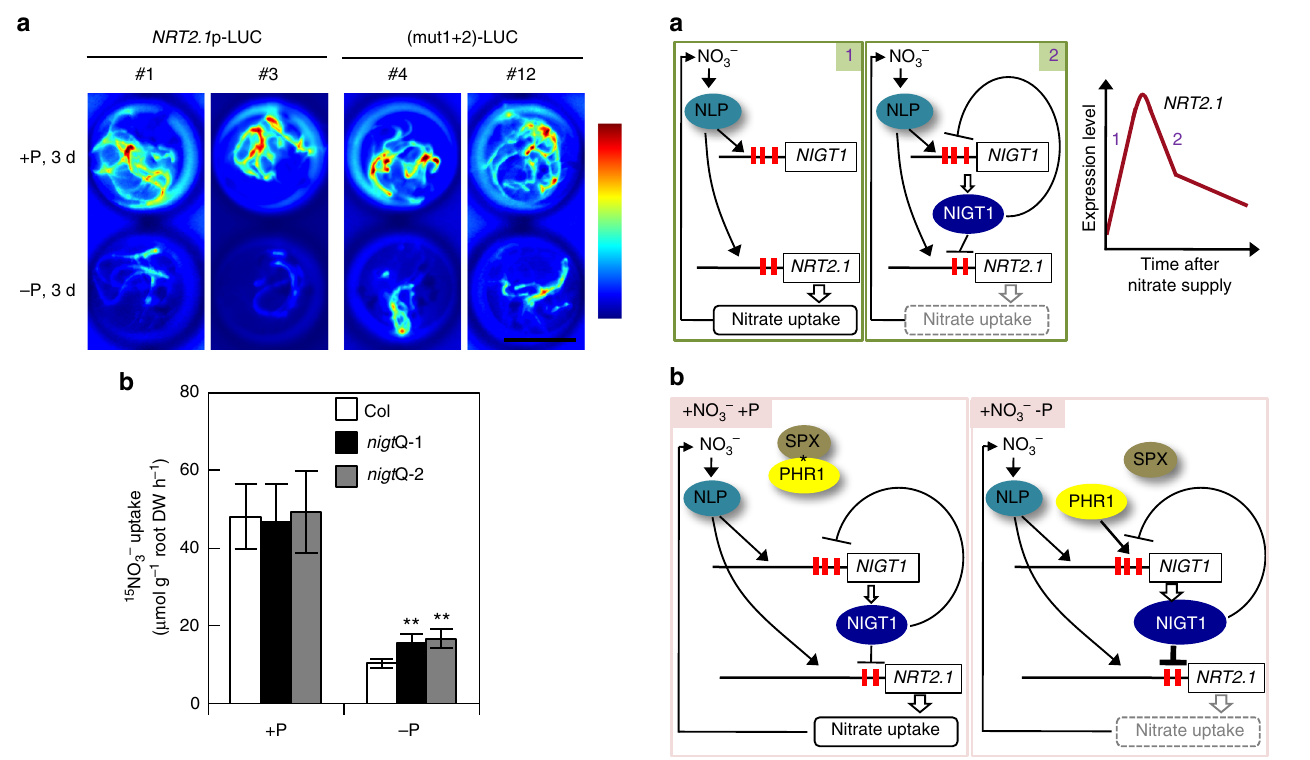
Fig. 8 The PHR1-NIGT1 cascade modulates nitrate uptake. a NIGT1-binding site-mediated P-starvation response of NRT2 . 1 promoter activity. Fig. 9 Model for the NIGT1-centred transcriptional cascade. a Model for the